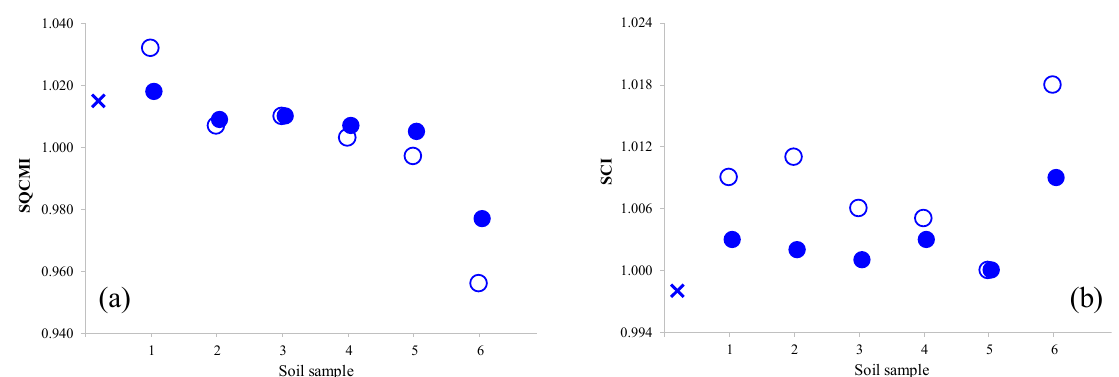
Figure 4. Soil Quartz Clay Mineral Index (SQCMI) ( a ) and Soil Carbonate Index (SCI) ( b ) values of soil samples: without dust_1 (empty circles), and covered with 50 g m − 2 dust_1 (filled circles); x represents the index values of dust_1.